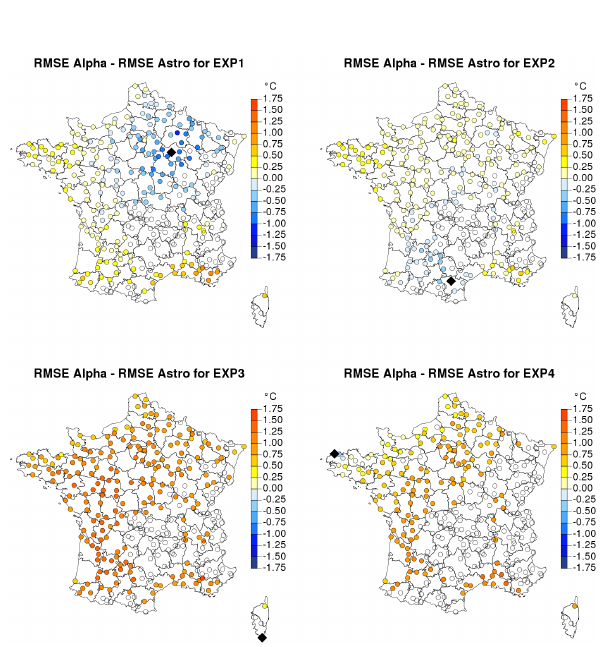
Figure 2. Comparison of the RMSE between alpha and astro for the four extreme experiments over 318 independent stations (circle). RMSE alpha–RMSE astro is represented by colours of the circles’ background: cold (warm) colours show that alpha is better (worse) than astro. White circle for station where the alpha method cannot be applied (because of the elevation criterion). The black diamond is the location of the hourly observation used to deduce pseudo- observation.